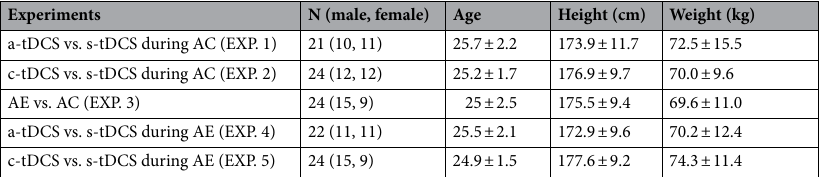
Table 3. Descriptive anthropometric data in all five experiments. AC = active control, AE = aerobic exercise. Mean ± standard